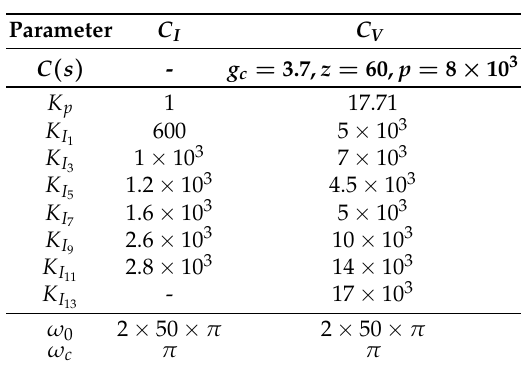
Figure 5. Bode diagram. Table 1. Controller’s